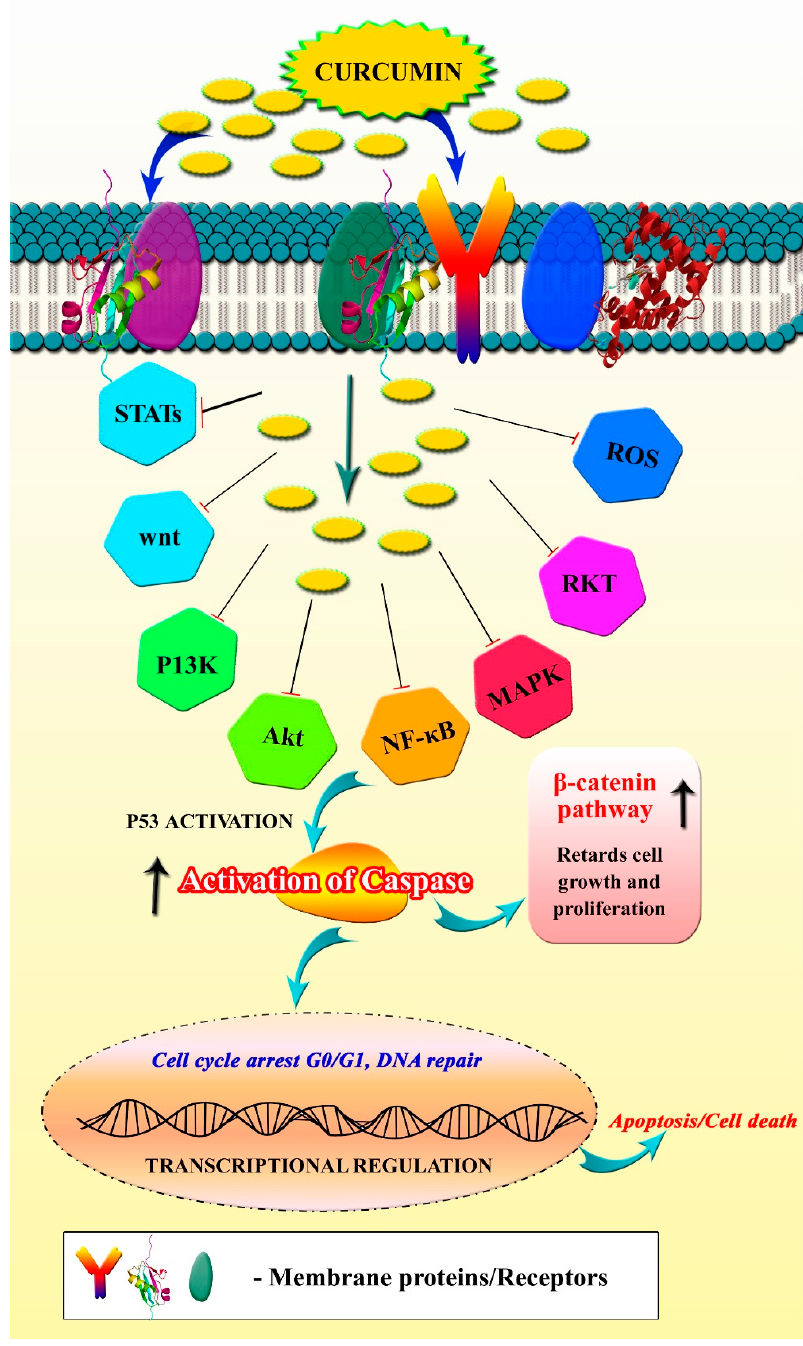
Figure 4. Anticancer mechanism of curcumin. Image shows the regulatory tar- gets/pathways of curcumin in anticancer